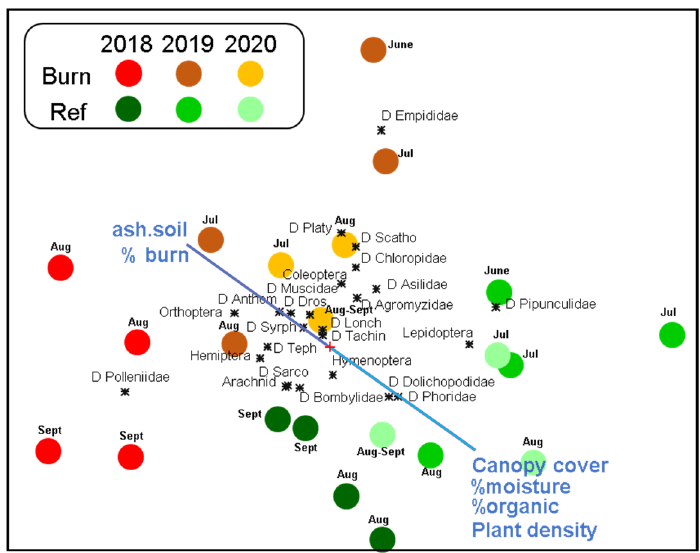
Figure 6. NMDS results for Altona fire versus reference study sites. * indicates insect taxon, circles indicate burn and reference study sites and year. Environmental variables associated with burn and reference sites are shown in blue. NMDS ordination stress was <0.10, using Sørensen’s similarity to determine ordination distance. All Diptera families are labeled as D, followed by family name or abbreviation.